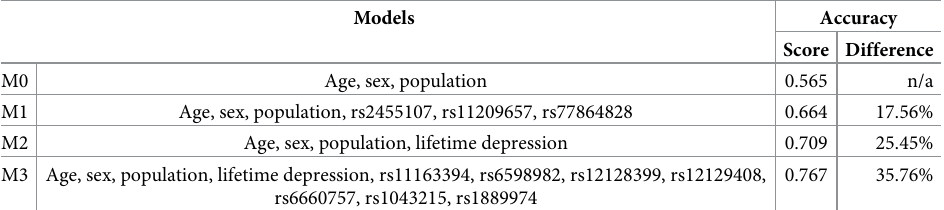
Table 5. Predictive power of multivariate models compared to a baseline containing age, sex and population